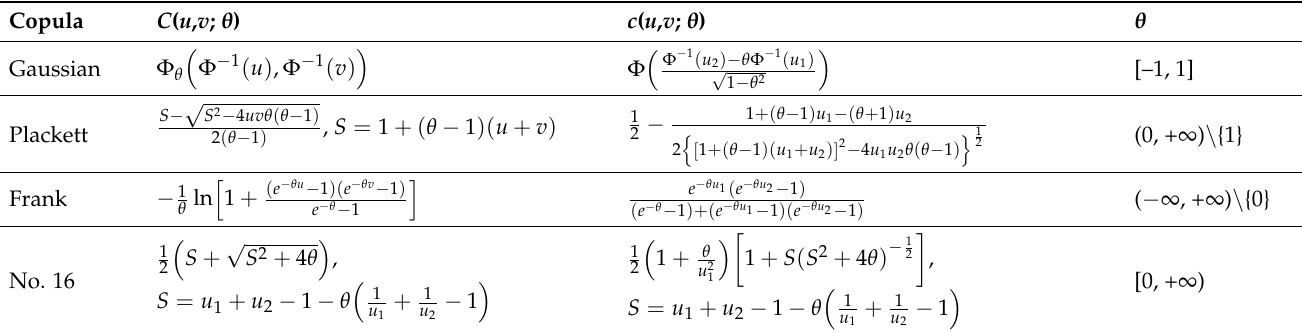
Table 1. CDFs and PDFs of candidate